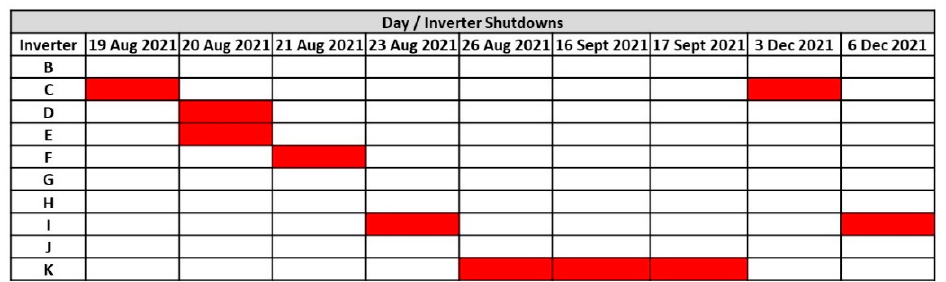
Figure 15. Inverter shutdown failures (colored in red) detected over the period from August to December 2021.